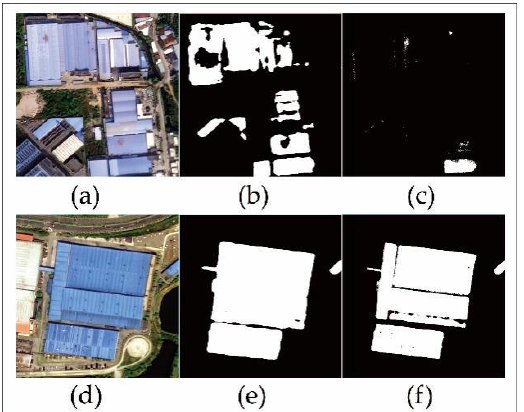
Figure 12. Comparison of the extraction results based on the deep learning method and the maximum likelihood classification method: ( a ) and ( d ) show the GF-2 images of the second and twelfth regions, respectively; ( b ) and ( e ) show the extraction results of the deep learning method in the second and twelfth regions, respectively; and (c) and ( f ) show the extraction results of maximum likelihood classification (MLC) in the second and twelfth region, respectively.